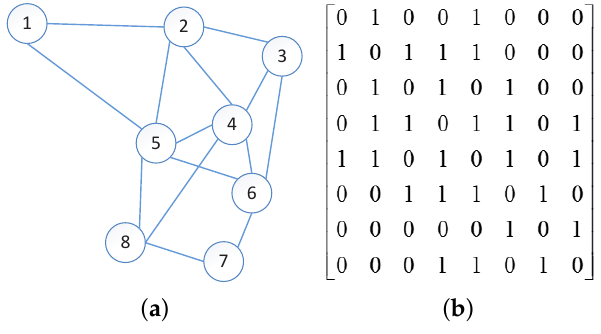
Figure 3. Diffusion Distance (DD): ( a ) Topological graph G 0 , ( b ) Adjacency matrix E